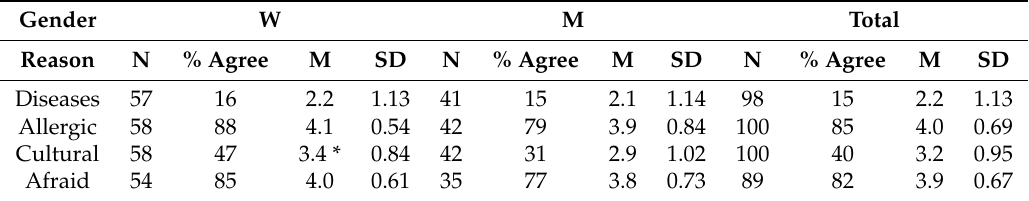
Table 1. Proportion of participants that agree / strongly agree and mean for reasons patients may not want to have a visit by a therapy dog in the emergency department (ED): Gender.